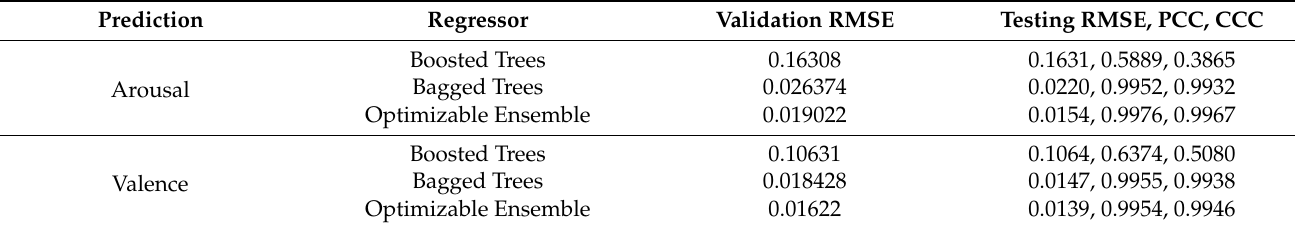
Table 2. Regression